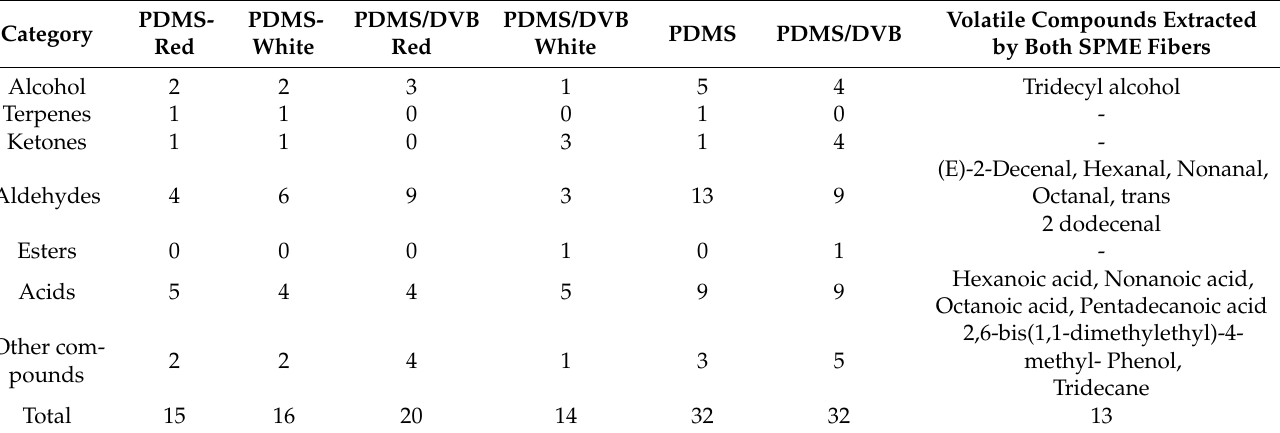
Table 4. Volatile profiles of between red and white pulp pitaya varieties detected by PDMS and PDMS/DVB